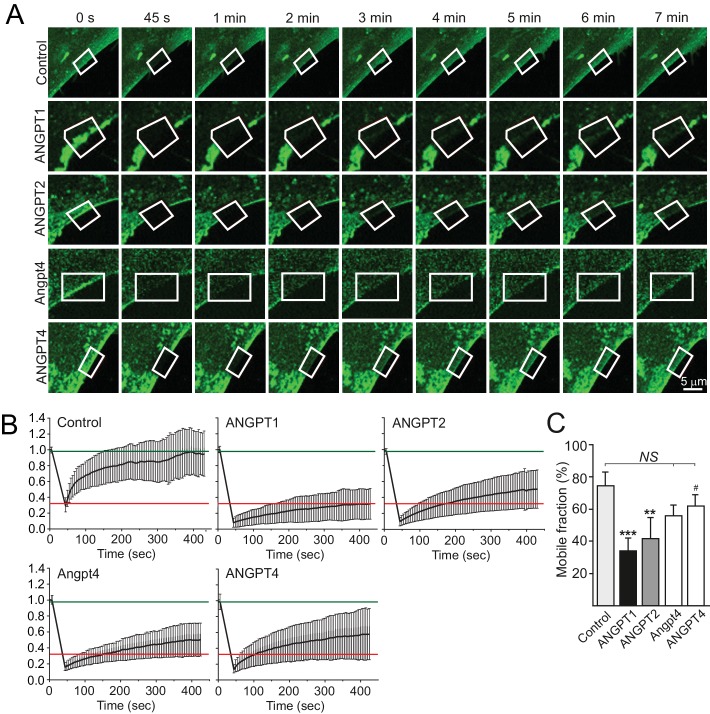
Fluorescence recovery of TIE2/angiopoietin complexes in FRAP analysis.(A) TIE2-GFP HUVECs were stimulated as indicated, ROIs (framed) at the retracting edges at the cell–ECM interface were photobleached and fluorescence recovery was followed every 5 s. Time point 0 s represents the prebleach situation, while 45 s shows the ROI after bleaching. (B) Normalized signal intensities from the fluorescence recovery follow-up. The curves following the normalized fluorescence intensity versus time (sec) in the ROI areas are shown for control and angiopoietin stimulated samples. Red and green lines indicate average TIE2/ANGPT1 (slowest fluorescence recovery) and control (fastest fluorescence recovery) values, respectively. (C) The mobile fraction was determined from the plateau point of the fluorescence recovery. n = 3 to 5 stimulations, 82 to 123 ROIs per stimulation were measured in each experiment. Mean ±SD, ANOVA followed by the Bonferroni post hoc test. ***p<0.001, **p<0.01 vs control; #p<0.05 vs ANGPT1.